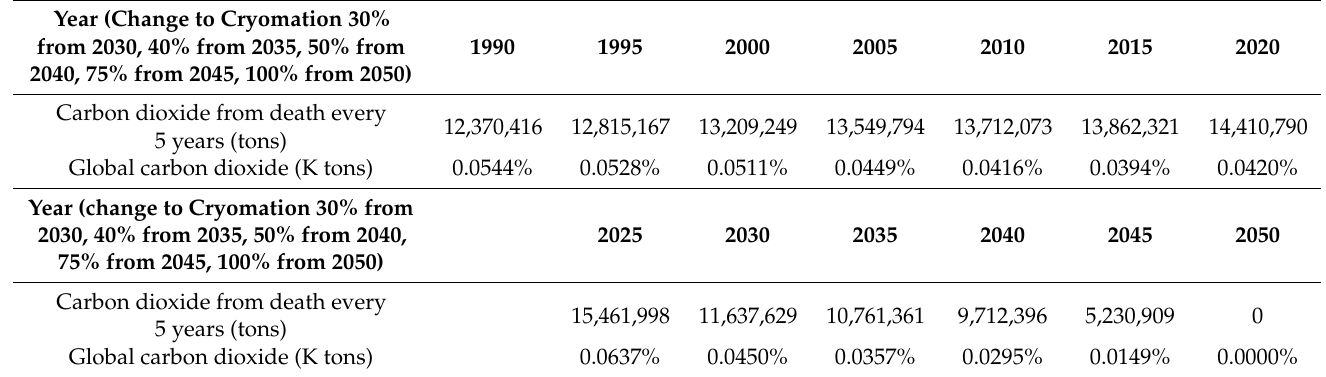
Table 5. The simulation of carbon dioxide generated from the death toll from 30% to 100% every 5 years between 2030 and